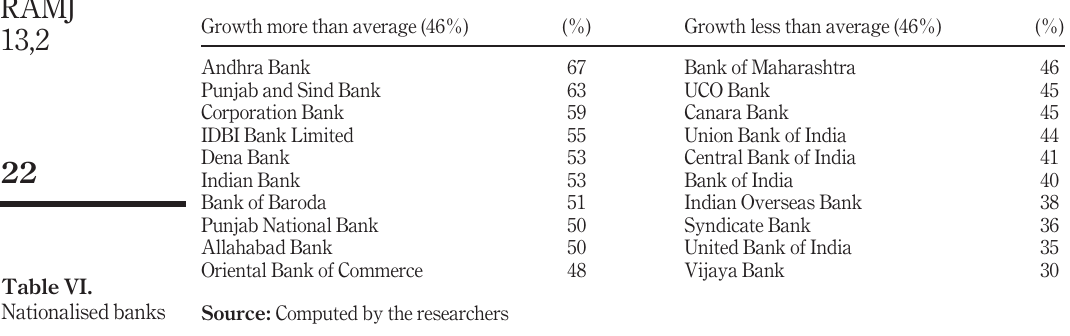
Growth more than average (46%)